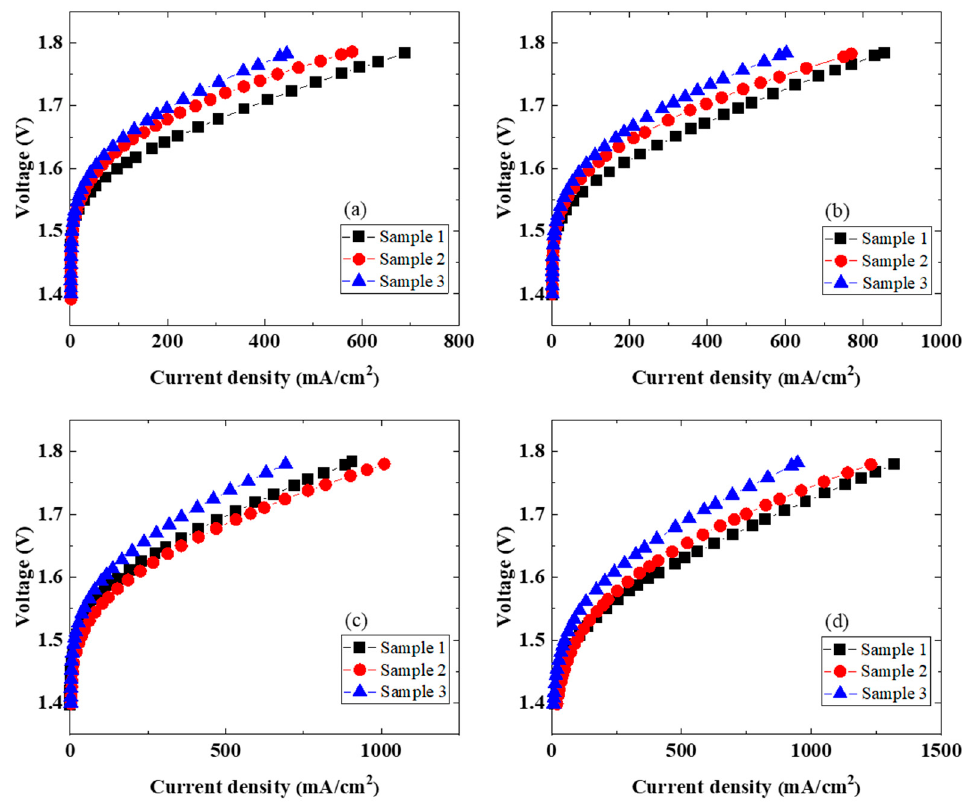
Figure 2. Polarization curves at different operation temperatures using the three IrO 2 catalyst electrodes (samples 1–3): ( a ) 80, ( b ) 100, ( c ) 120, and ( d ) 150 °C. Table 2. Current–voltage properties at different operating temperatures using different IrO 2 catalyst electrodes.